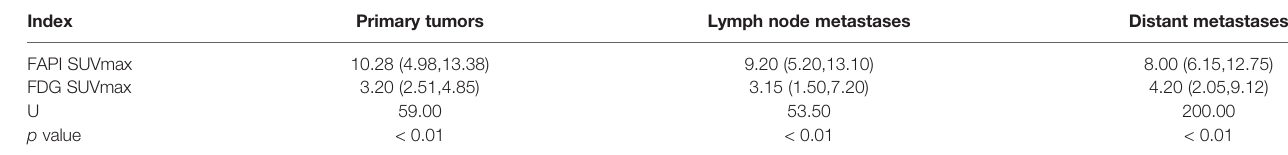
TABLE 2 | The SUVmax comparison between [ 18 F]-FDG and [ 68 Ga]Ga-FAPI-04 PET/CT in primary tumors, lymph node, and distant metastases.